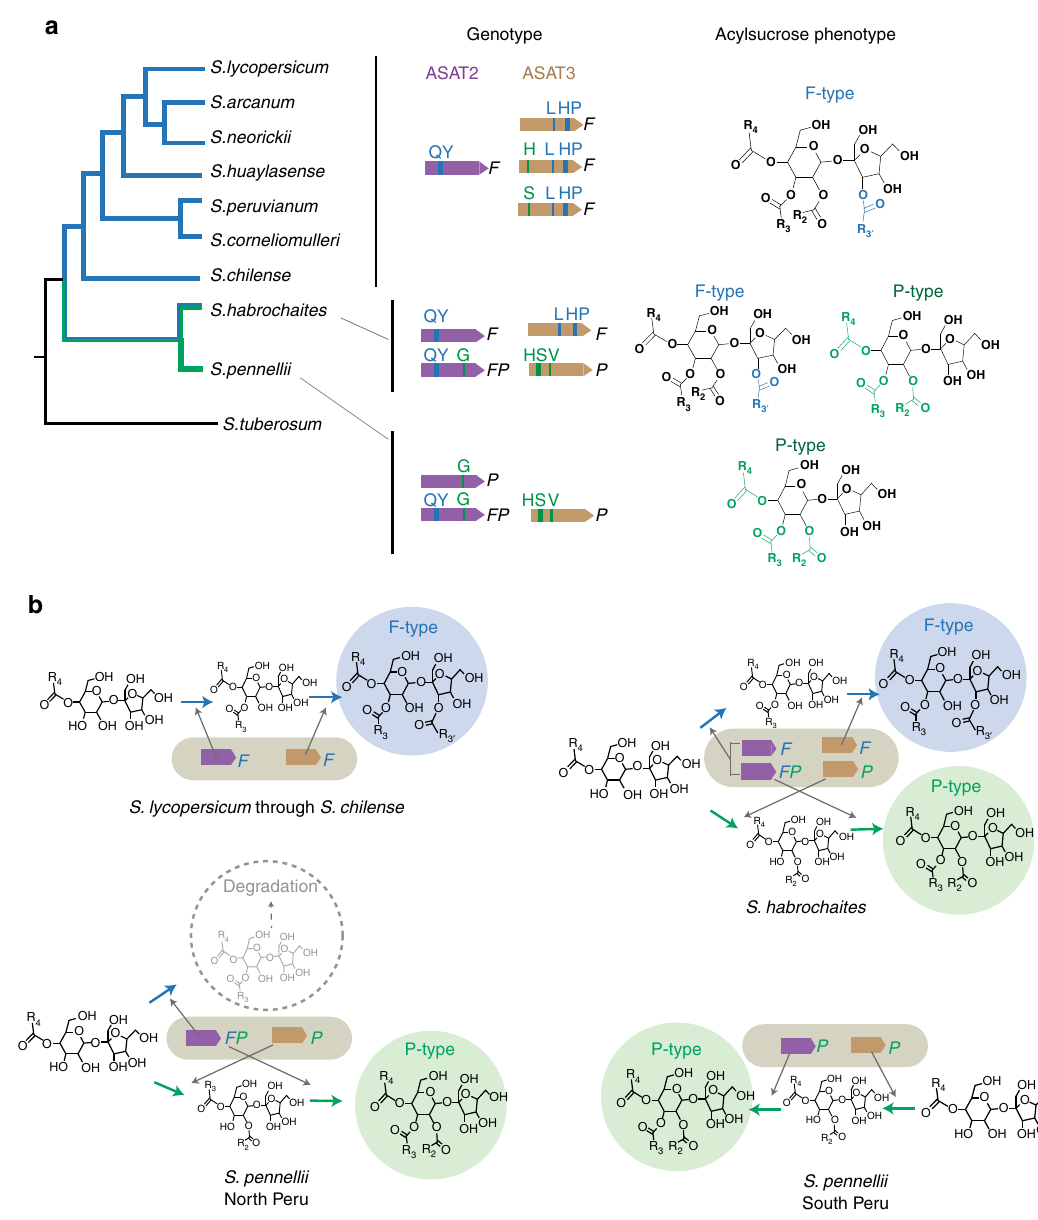
Fig. 6 Solanum tomato group ASAT2 and ASAT3 variant proteins in a phylogenetic context. a ASAT2 and ASAT3 variants cloned from different wild tomato species are assigned as F- or P- protein types based on residues identi fi ed by in vitro mutagenesis. Amino acids associated with F- or P-type activities are in blue and green, respectively. See Supplementary Figs. 11 and 12 for detailed gene phylogenies. The plant trichome F- or P- acylsucrose phenotypes are based on published results. There are NMR structural data for acylsugars from S. lycopersicum , S. habrochaites and S. pennellii 28,30 , while LC/MS data exist for all species listed 27 . b Summary of the types of ASAT and product combinations found in the tomato clade. The combination of ASAT2 and ASAT3 enzyme types in different tomato species was inferred based on the activity-associated residues as shown in a . Degradation of the dead end diacylsucrose is based on published results for loss of function S. lycopersicum ASAT3 27 and characterization of acylsucrose hydrolases in S. lycopersicum and S. pennellii